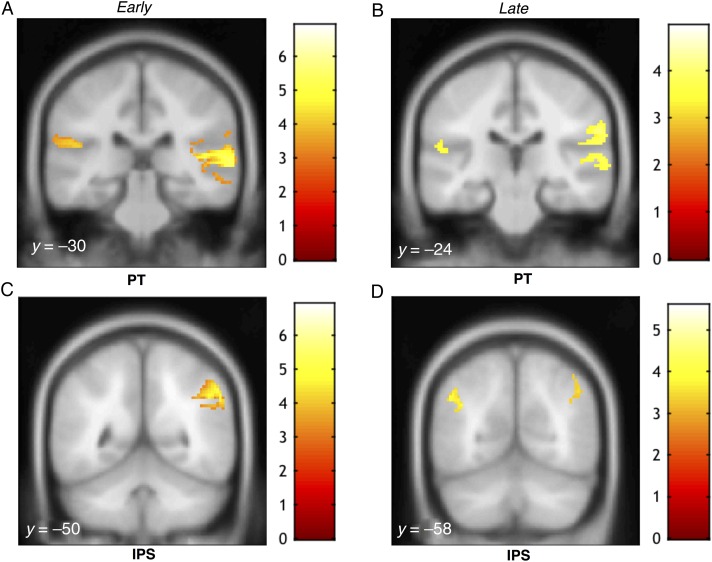
MEG source activations as a function of coherence for the basic SFG stimulus. Activations (thresholded at P < 0.001, uncorrected) are shown on the superior temporal plane of the MNI152 template image and the corresponding y coordinates are overlaid on each image. The heat map adjacent to each figure depicts the T value. Coordinates of local maxima are provided in Table 1. Maximum response during the early transition period was observed in PT and right inferior parietal cortex (A) as well as in the right IPS (C). Activity during the later response window was observed in PT bilaterally and the right inferior parietal cortex (B) as well as in both the left and right IPS (D).